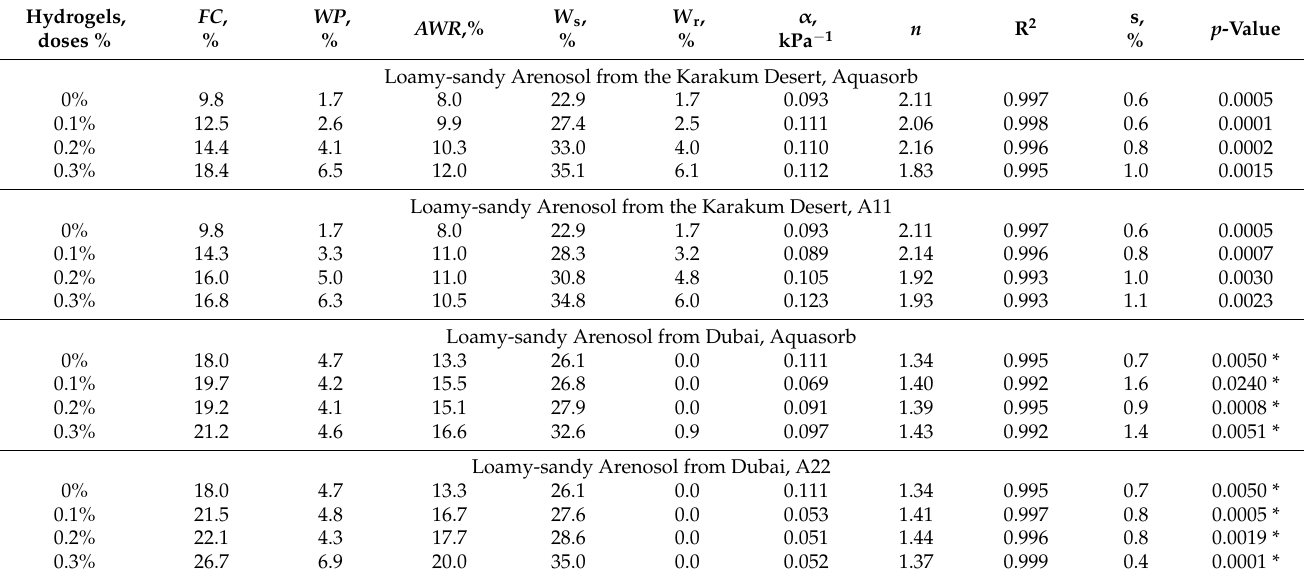
Table 6. Estimated parameters of water retention in mineral-gel compositions with loamy sandy